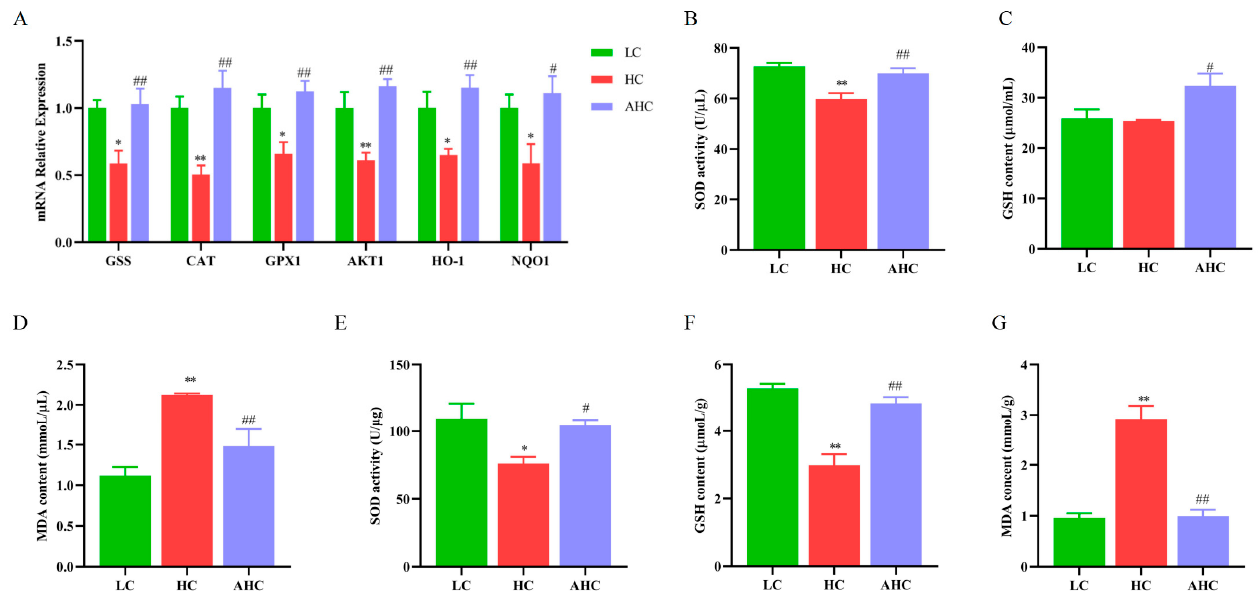
Figure 6. The effects of disodium fumarate supplementation in the high-concentrate diet on oxidative stress-related genes in mammary gland tissue and oxidative stress-related indicators in plasmid and mammary gland tissue. The relative mRNA abundance of the genes related to oxidative stress in the mammary gland tissue of Hu sheep ( A ); the activity of SOD ( B ), the concentration of MDA and GSH in blood ( C , D ) and mammary gland tissue ( E – G ) in Hu sheep. Data are presented as the relative protein abundance relative to actin (means ± SEM), * p < 0.05, ** p < 0.01 represent significant differences compared with the LC diet. # p < 0.05, ## p < 0.01 represent significant differences compared with the HC diet.